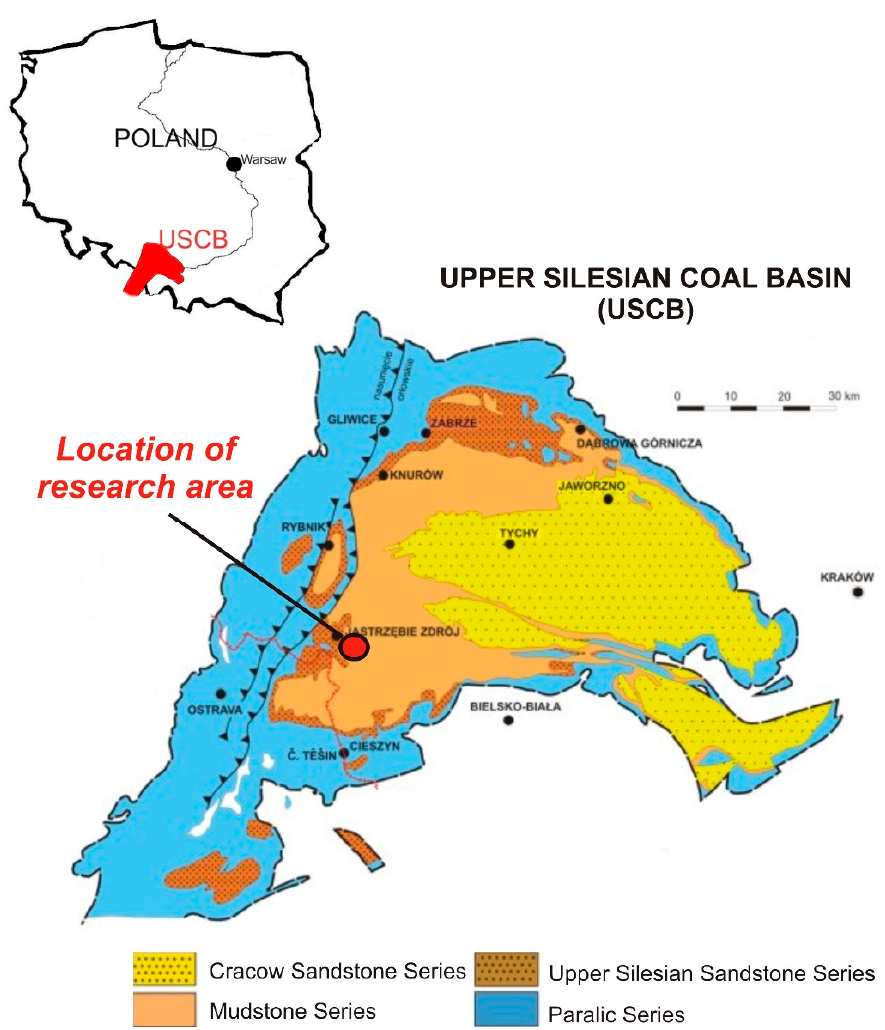
Figure 3. Location of research area in the part of Upper Silesian Coal Basin [53].